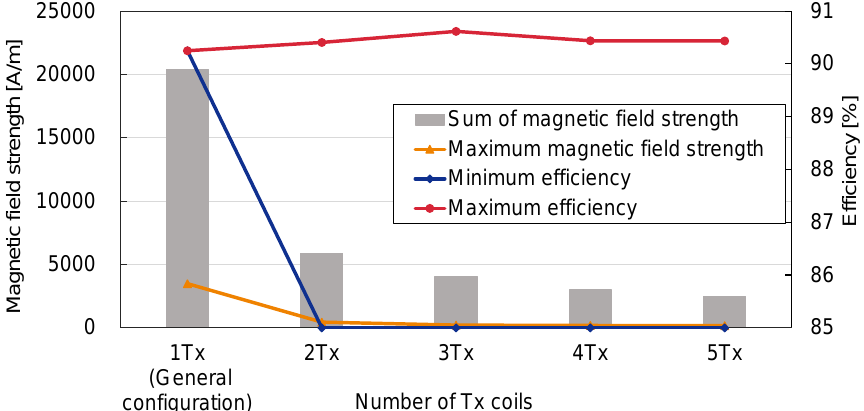
Figure 8. Comparison of magnetic field strength and transmission efficiency for each number of transmission (Tx) coils ( α =